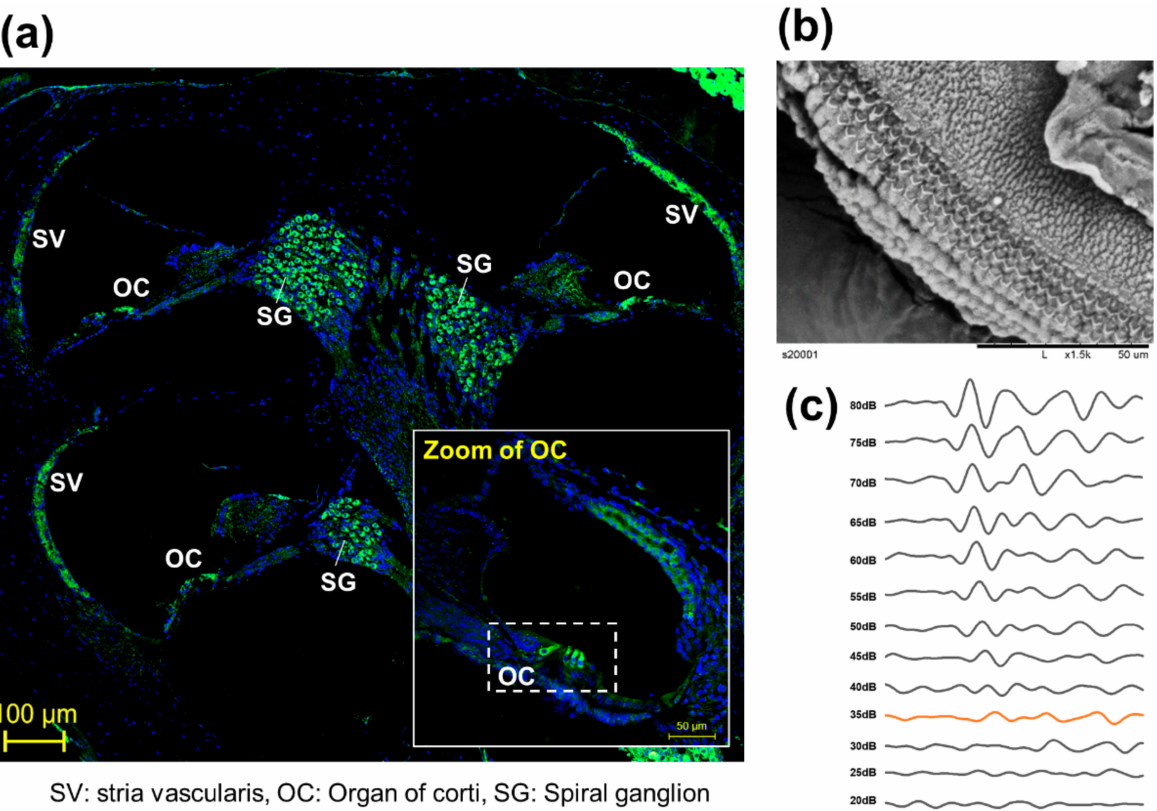
Figure 2. Representative anatomical analysis strategy for in vivo experiments. ( a ) Analysis of whole auditory organ by immune fluorescence staining using Myosin 7a (Myo7a). (Myo7a: green, DAPI: blue), ( b ) Observation of organ of corti (OC) by transmission electron microscopy [8], ( c ) Comparison of hearing kinetics depending on 80 db to 20 dB on 8000